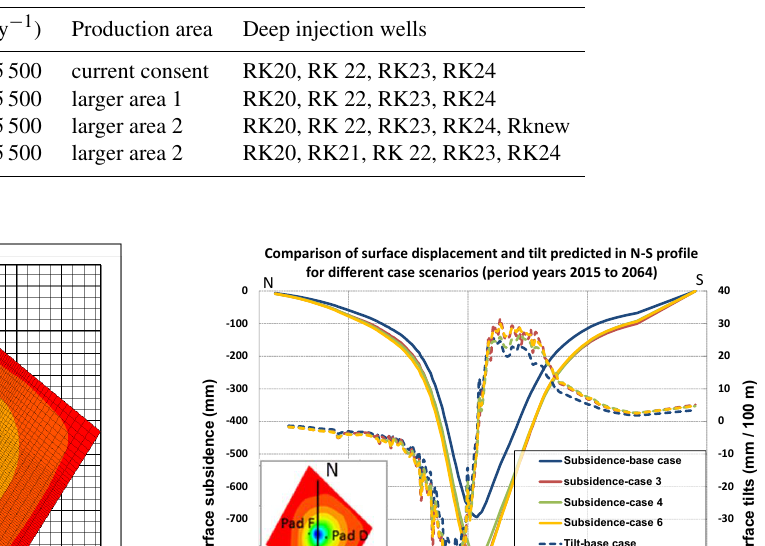
Figure 5. Comparison of surface displacement between measured data in mm (a) and history match result in m (b) for 2009–2013 – white dots in the left plot show the locations of the measurement points. Table 1. Simulation matrix for future prediction scenarios.